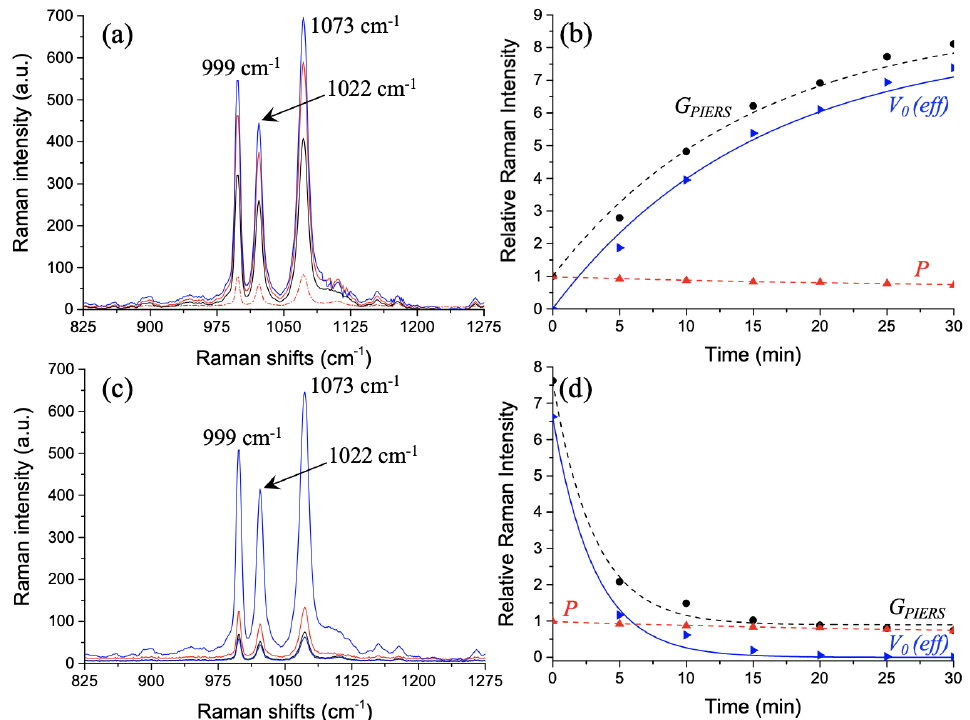
Figure 2. ( a ) Raman spectra for a UV-irradiation time of 0 min (the red dashed line, SERS spectrum serving as a reference), 10 min (in black color, PIERS spectrum), 20 min (in red color, PIERS spectrum) and 30 min (in blue color, PIERS spectrum). ( b ) Variation recorded for the relative Raman inten- sity of the peak at 1073 cm − 1 called G PIERS (experimental points = full black circles; fitting curve (R 2 = 0.965) = black dashed curve) under UV irradiation, where G PIERS can be expressed by employ- ing Equation (1), where V 0 ( eff ) corresponds to the effective number of oxygen vacancies (experimental points = blue full triangles; fitting curve (R 2 = 0.968) = blue curve), and P corresponds to the photo- bleaching (experimental points = red full triangles; fitting curve (R 2 = 0.972) = red dashed curve). ( c ) Raman spectra for a relaxation time of 0 min (in blue color), 10 min (in red color), 20 min (in black color) and 30 min (in dark color) after stopping UV irradiation. ( d ) Variation recorded for the relative Raman intensity of the peak at 1073 cm − 1 called G PIERS (with the same correspondence reported in ( b ) for full black circles and black dashed curve (R 2 = 0.993)) after UV irradiation, where G PIERS can be expressed by employing Equation (1), where V 0 ( eff ) corresponds to the effective number of oxygen vacancies (with the same correspondence reported in ( b ) for the blue triangles and blue curve (R 2 = 0.994)), and P corresponds to the photobleaching (with the same correspondence reported in ( b ) for the red triangles and red dashed curve (R 2 =